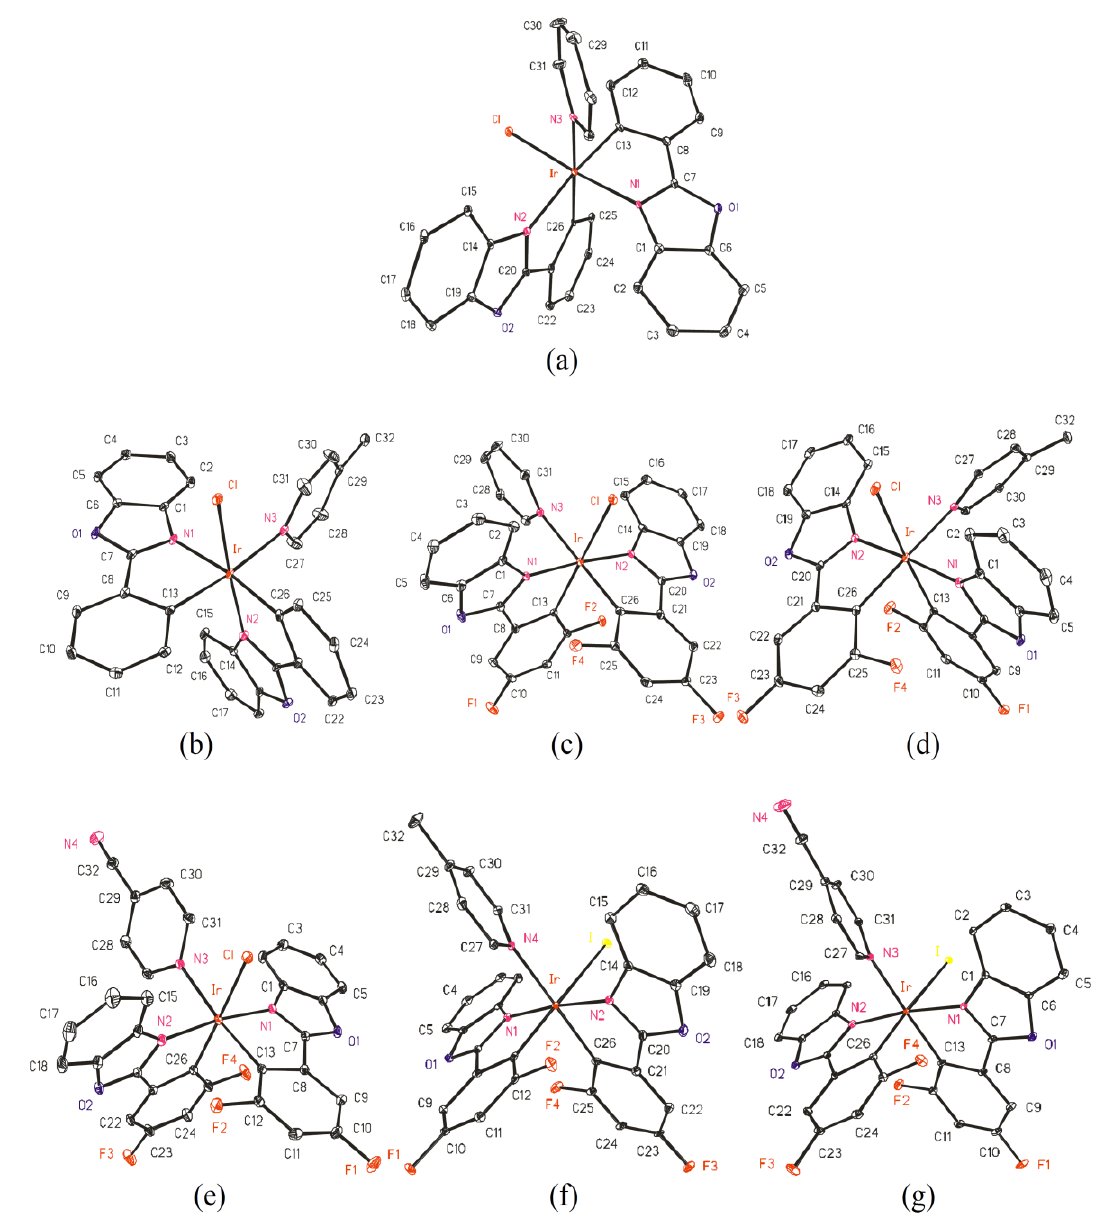
Figure 1. X-ray crystal structures of ( a ) (pbo) 2 Ir(Cl)(py) ( 1 ); ( b ) (pbo) 2 Ir(Cl)(4mpy) ( 2 ); ( c ) (dfpbo) 2 Ir(Cl)(py) ( 4 ); ( d ) (dfpbo) 2 Ir(Cl)(4m py) ( 5 ); ( e ) (dfpbo) 2 Ir(Cl)(4cnpy) ( 6 ); ( f ) (dfpbo) 2 Ir(I)(4m py) ( 8 ); and ( g ) (dfpbo) 2 Ir(I)(4cnpy) ( 9 ). Thermal ellipsoids are draw at the 20% probability level. The hydrogen atoms and solvent are omitted for clarity.